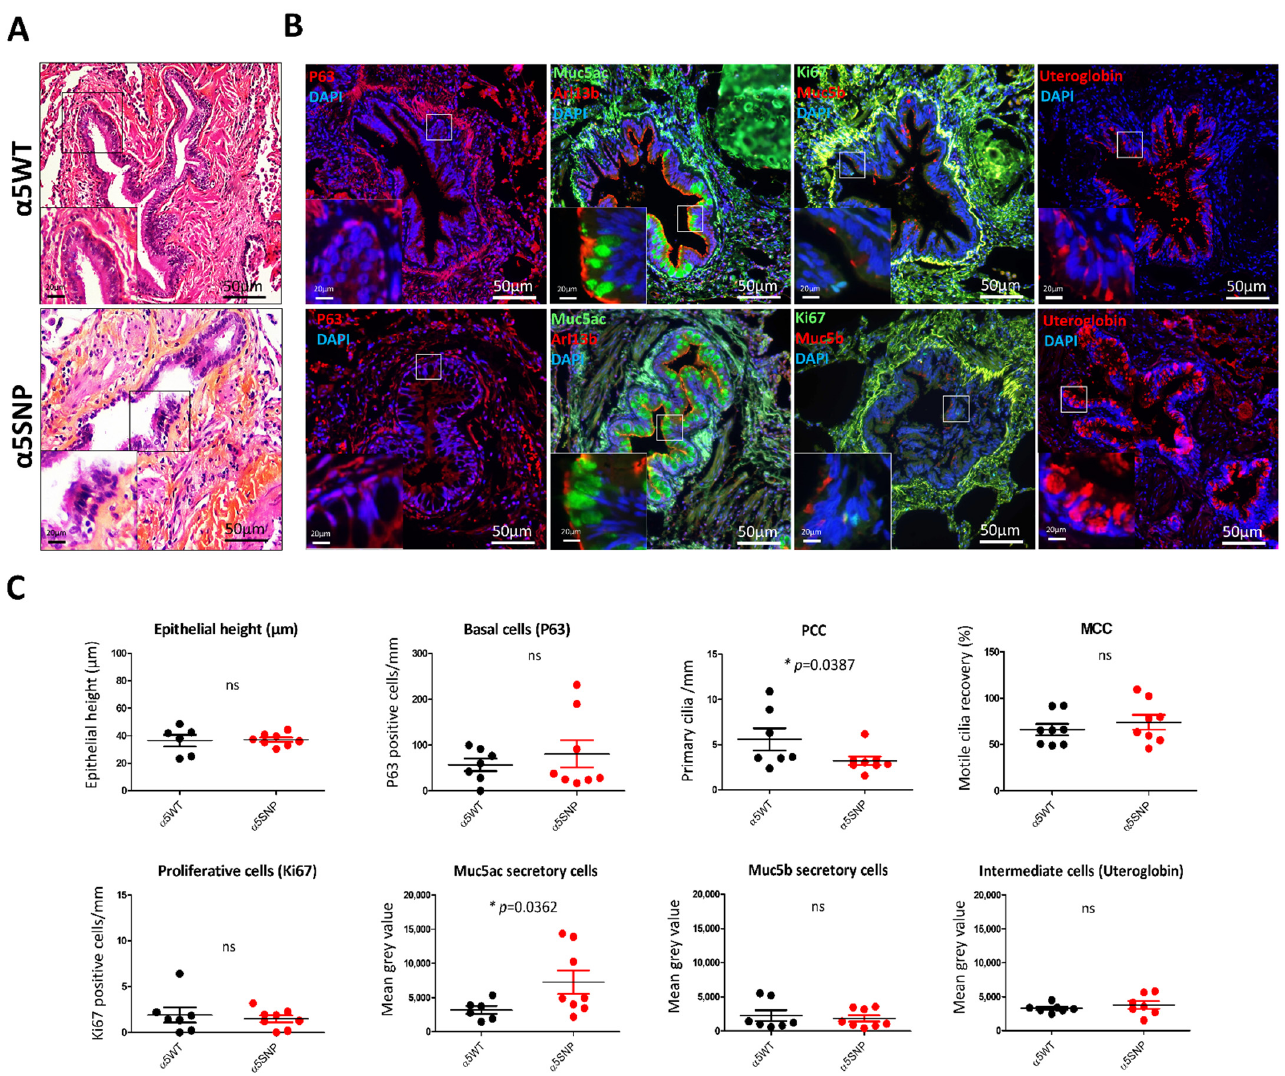
Figure 2. Bronchiolar epithelial remodeling in rs16969968 ( α 5SNP) COPD patients. ( A ): Hematoxylin and eosin staining showing the epithelial height of α 5SNP and α 5WT COPD patients. ( B ): Examples of the microscopic acquisition of immunofluorescent stainings for basal cells (P63, red), ciliated cells (Arl13b, red), proliferative cells (Ki67, green), mucins secretory cells (Muc5ac, green; Muc5b, red), and intermediate cells (Uteroglobin, red). Nuclei are stained in blue (DAPI). Magnification corresponding to the selected area is represented. ( C ): Dot plots (means with SEM) representing measurements of the epithelial height, the number of basal, proliferative, and primary ciliated cells per mm, motile cilia recovery (%), and the mean grey values of mucins (Muc5ac, Muc5b) and uteroglobin-associated fluorescence of α 5SNP and α 5WT COPD patients. *, p < 0.05 α 5WT vs. α 5SNP; ns, non-significant. In contrast, when compared with α 5WT, α 5SNP bronchiolar epithelium was